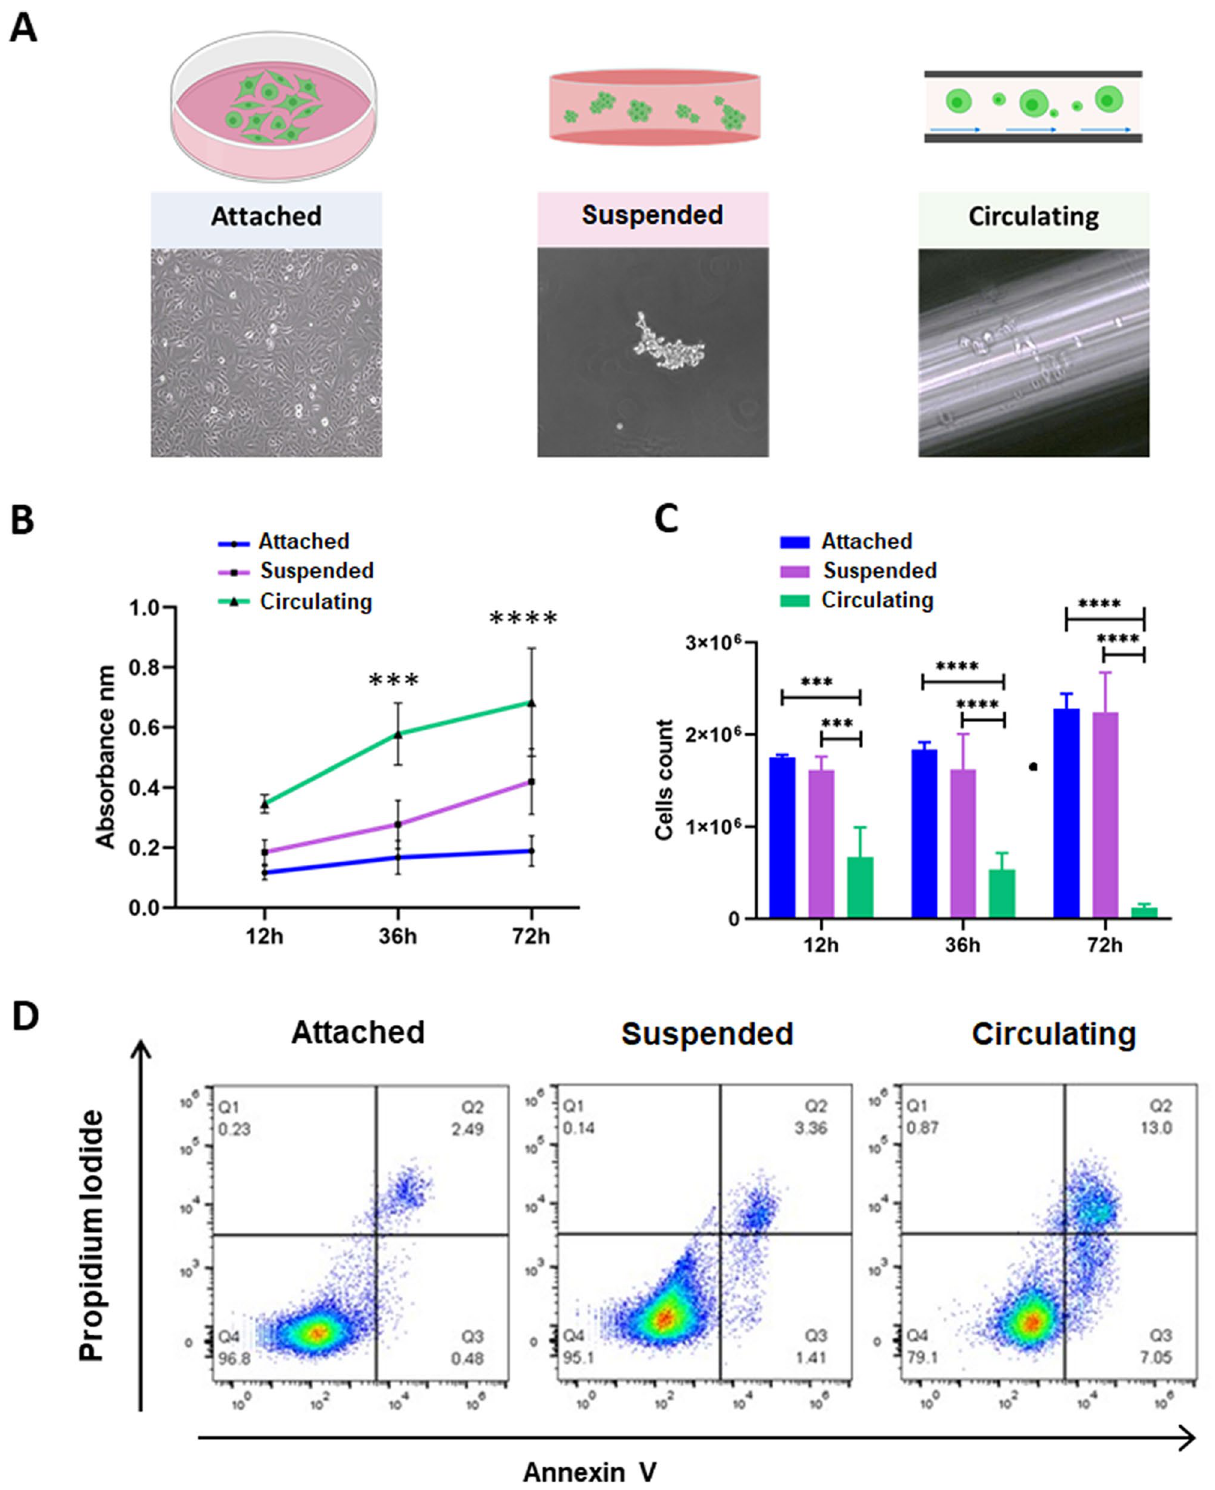
Figure 3. Circulation decreases primary lung cancer cell viability over time. Lung cancer cell viability was assessed using LDH and trypan blue for adhered, suspended, and circulatory primary lung cancer cells at different time points. Annexin V was performed to evaluate cell viability at 72 h. ( A ) Experimental conditions. Cells seeded in monolayer (attached), cells in suspension and cells in circulation. ( B ) LDH assay comparison over time. LDH assay showed that cellular damage increases significantly in cells subjected to circulation after 36 h, while cells in suspension experience significant cellular damage at 72 h as compared to attached cells 72 h (2-way ANOVA test, p < 0.005). ( C ) Cell counting comparison . Trypan blue assay showed that there was a significant decrease in cells in circulation starting at 12 h in circulation and most different at 72 h as compared to adhered and suspended cells (2-way ANOVA test, p < 0.0001). ( D ) Representative flow cytometry profiles and percentages of Annexin V+ cells, circulation increases apoptosis cell death during circulation in cancer cells after 72 h in circulation.; Q1: Necrosis, Q2: Late apoptosis, Q3: Early apoptosis, Q4: Live